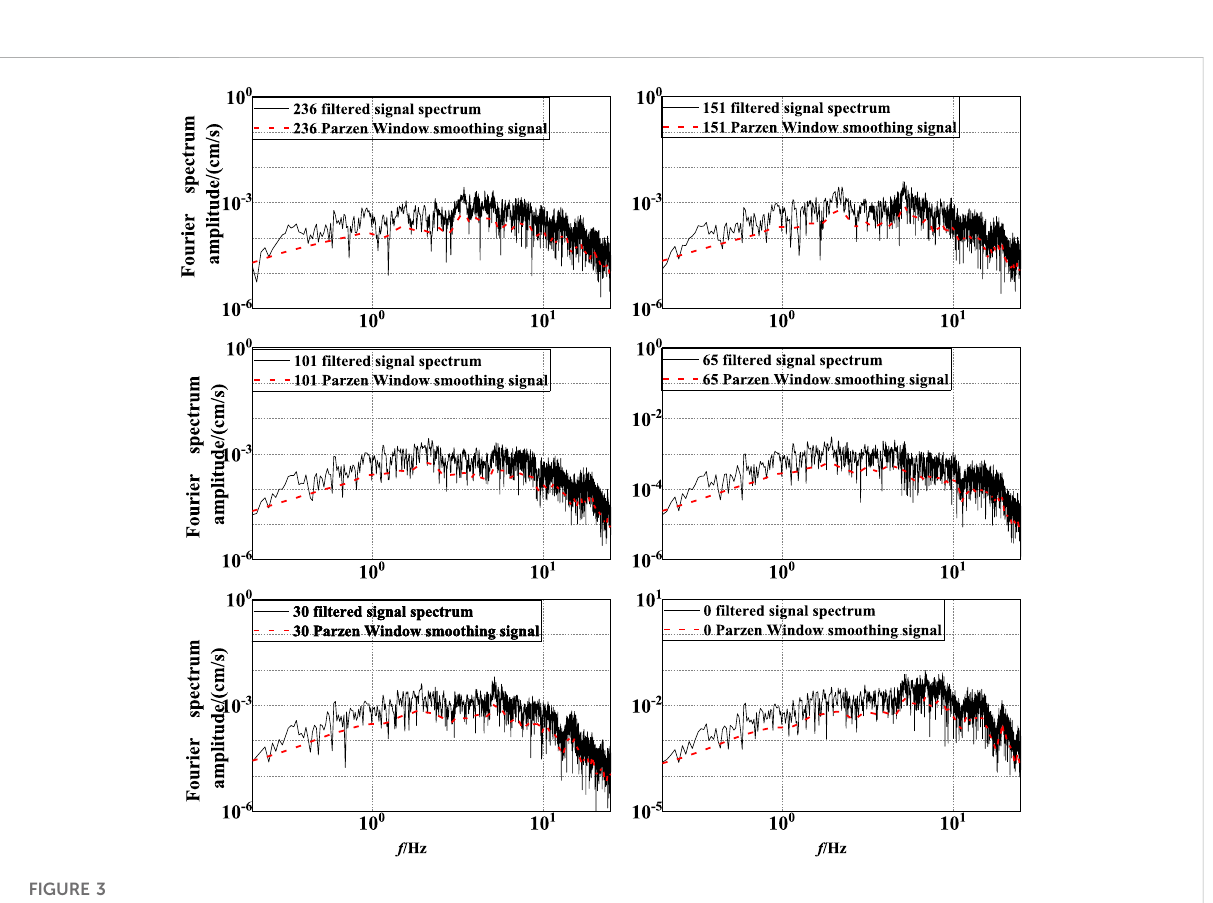
FIGURE 3 Guye strong motion record smoothing effects (vertical